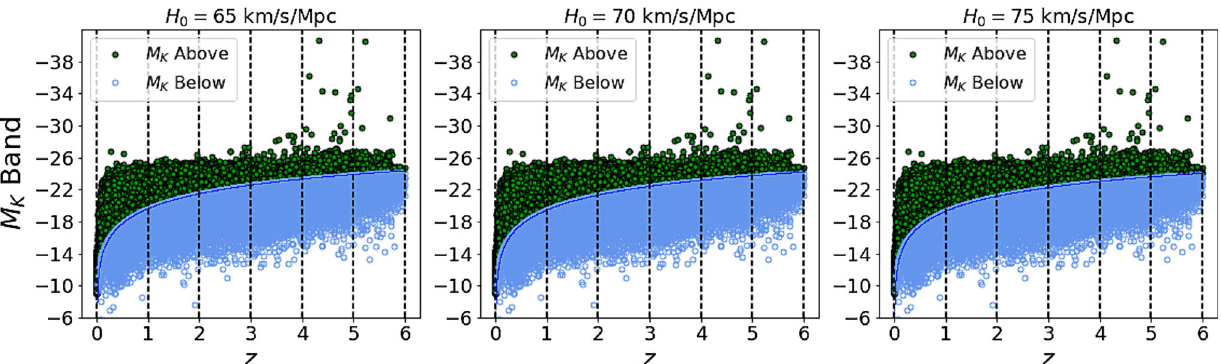
Fig. 2 Plot of the absolute magnitudes for the COSMOS2015 galaxies intermsofoftheirphotometricallymeasuredredshiftvalues.Thedivid- ing line corresponds to apparent magnitude K = 24 . 7 and only galaxies